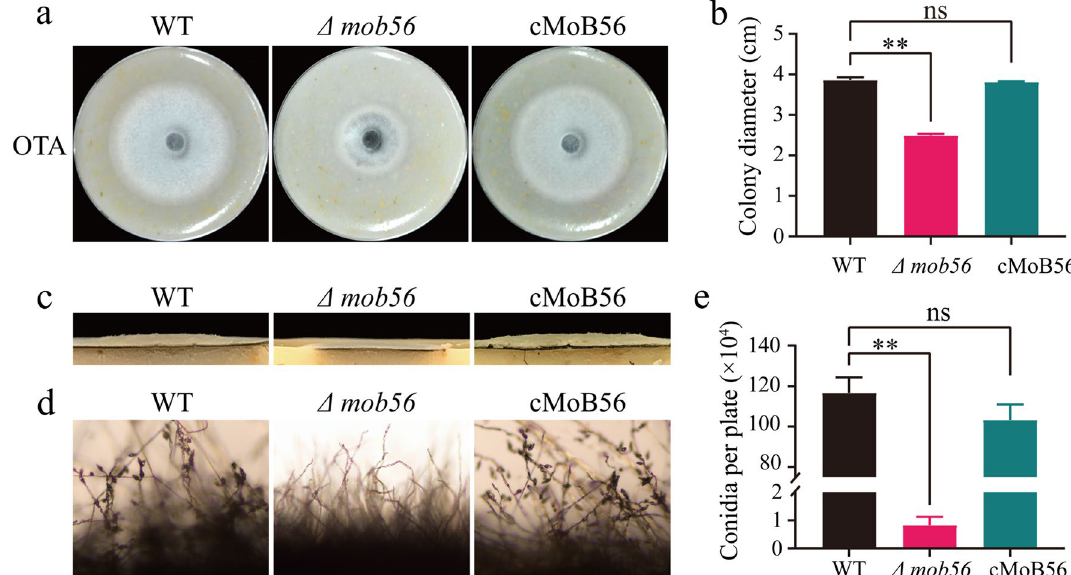
Fig. 2 MoB56 is required for mycelial growth and conidiation in Magnaporthe oryzae . a Colony morphologies of the wild‑type (WT) strain, the Δmob56 deletion mutant and the complementary strain cMoB56 grown on an OTA plate at 28°C for 5 days. b Colony diameters of the indicated strains. c Aerial hyphal growth of the indicated strains. d Conidiophore development of the indicated strains. e Statistical analysis of conidial numbers of the indicated strains grown on OTA plate at 28°C for 7 days. Error bars represent